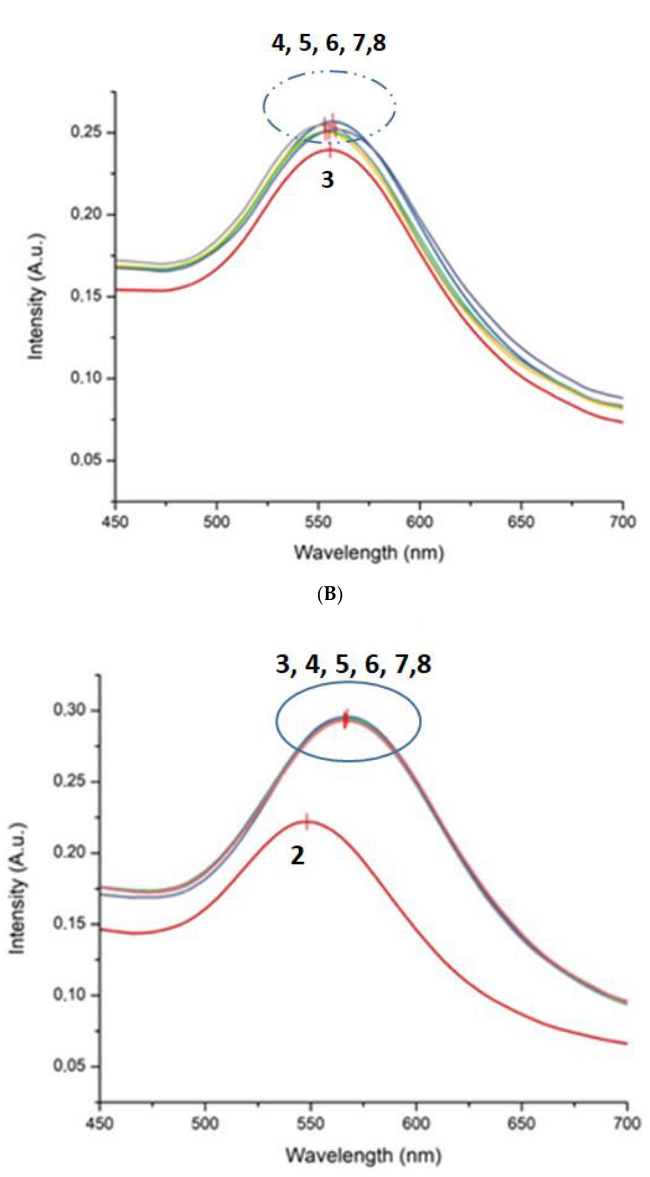
Figure 7. LSPR spectra of two sets of control experiments recorded for five gliadin concentrations ( A ) in the absence of anti-IgG gliadin antibody and ( B ) in the presence of non-specific anti-IgG BSA-antibody suspended in aqueous solution (1) annealed 4 nm AuNPs; (2) MUA/AuNPs; (3) anti- gliadin/MUA/AuNPs; (4) 0.1 ppm gliadin; (5) 1 ppm gliadin; (6) 10 ppm gliadin; (7) 100 ppm gliadin and (8) 1000 ppm gliadin. (A.u.—absorbance